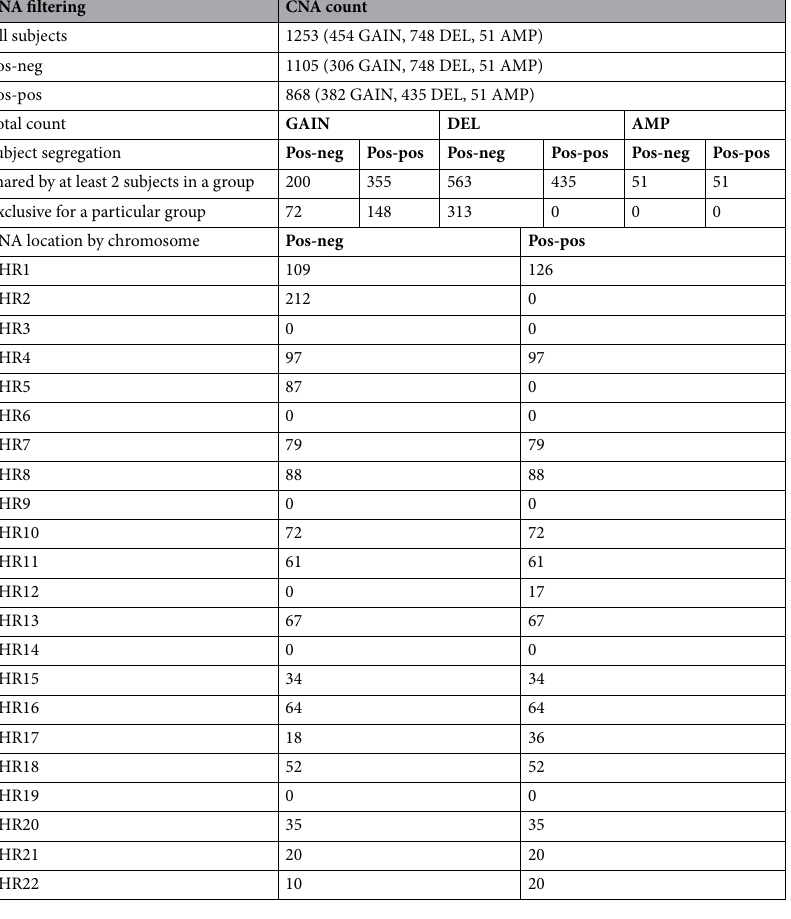
Table 2. Copy Number Alteration count for study subjects and stratified by subject’s group according to ichorCNA. CNA Copy Number Alteration, Pos-neg Positive–negative subjects, Pos-pos